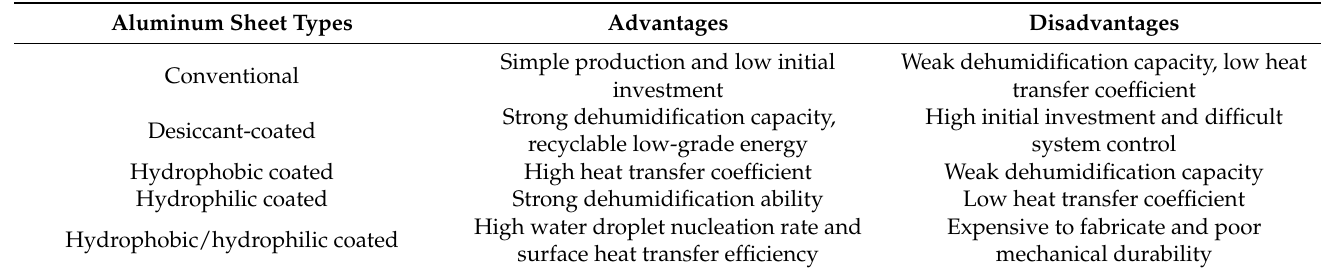
Table 1. Types of aluminum fins and their